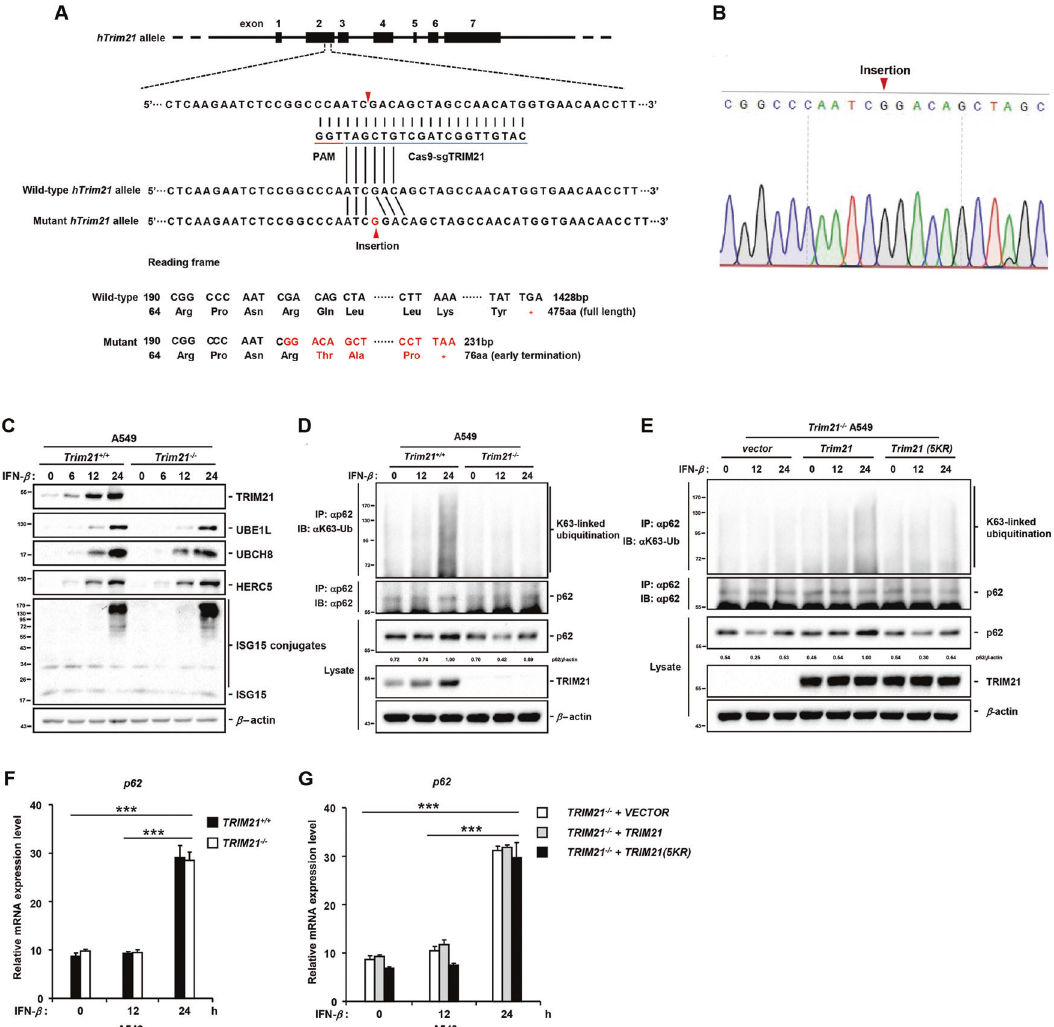
( B ). C TRIM21 + / + and TRIM21 − / − A549 cells were treated with IFN- β for indicated timepoints. Cell lysates were lysed in RIPA buffer and then subjected to western blot analysis to detect the protein levels of TRIM21, UBE1L, UCBH8, HERC5, ISG15, and ISG15 conjugates. D Lysates of TRIM21 + / + and TRIM21 − / − A549 cells treated with IFN- β for indicated timepoints were immunoprecipitated in denaturing RIPA buffer with anti- p62 antibody at 4 °C overnight, followed by immunoblotting analysis to detect indicated proteins. E Lysates of IFN- β -treated TRIM21 -/- A549 cells stably expressing VECTOR, TRIM21, or TRIM21(5KR) mutant were immunoprecipitated in denaturing RIPA buffer with anti-p62 antibody at 4 °C overnight, followed by immunoblotting analysis to detect indicated proteins. F-G p62 transcripts of IFN- β -treated TRIM21 + / + and TRIM21 − / − A549 cells ( F ) or TRIM21 − / − A549 cells stably expressing VECTOR, TRIM21, or TRIM21(5KR) mutant ( G ) were measured by qRT-PCR. Data were analyzed with Two-way ANOVA, and represented as mean ± standard error of the mean (n.s. not signi fi cant. *** P < 0.001). Data shown are representative of three independent wild-type TRIM21, but not the TRIM21(5KR) mutant, into TRIM21 − / − A549 cells reduced the number and size of co- located p62 puncta in autophagosomes 24 h after IFN- β treatment (Figs. 6B, D and S7D). Nonetheless, there seemed to be no signi fi cant differences in the numbers of total LC3B puncta between IFN- β -treated TRIM21 + / + and TRIM21 − / − A549 cells (Fig. S7A) or TRIM21 − / − A549 cells stably expressing empty vector, wild-type TRIM21, and TRIM21(5KR) mutant (Fig. S7B). It has recently been amply documented that TRIM21 functions as a cytosolic Fc receptor sensing incoming antibody-coated viruses and then inducing the expressing of type I IFNs through immune signaling as the fi rst wave immune response [16]. With